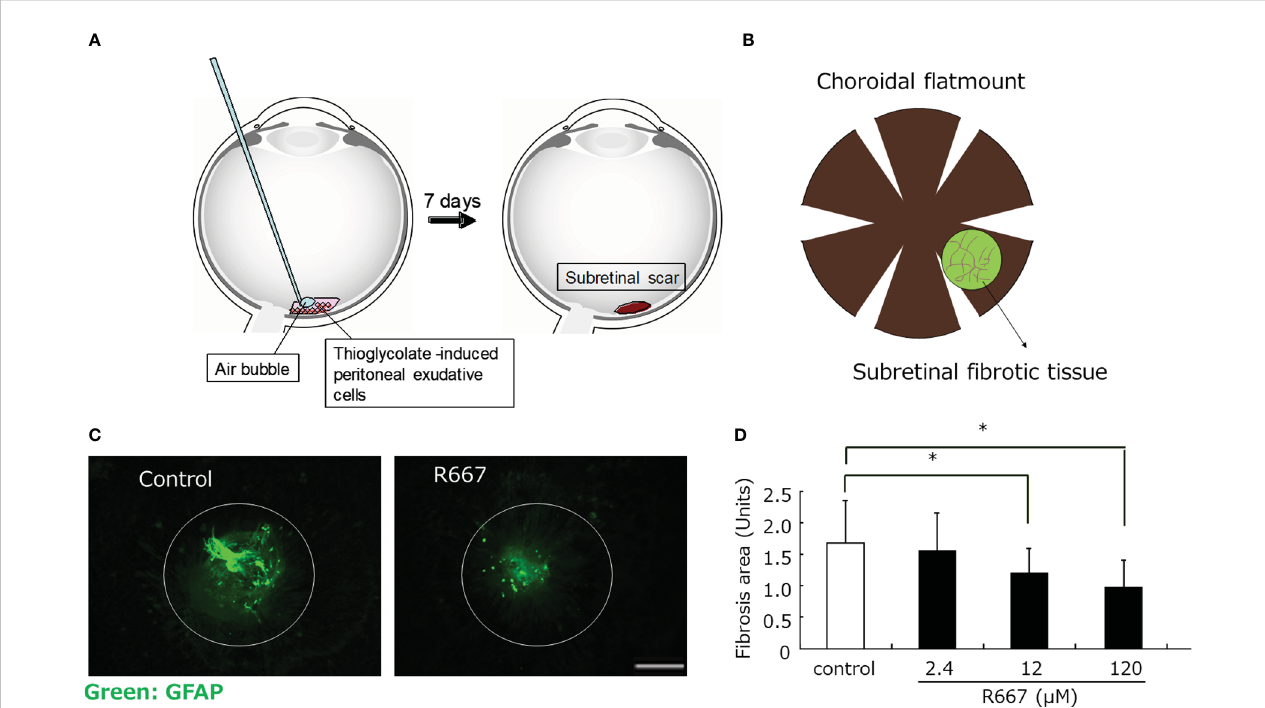
FIGURE 2 Inhibition of subretinal fi brosis by RAR- g agonist(R667) in a mouse model. (A) Retina was subjected to laser photocoagulation (light wavelength, 532 nm; time, 0.1s; spot size, 75 m m; power, 200 mW) in order to generate a subretinal bubble and rupture Bruch ’ s membrane. Thioglycolate-induced PECs (4×10 7 /ml) were exposed to various concentrations of R667 in PBS, and 0.5 m l of the cells was then injected into the subretinal space of the mouse recipients. Seven days after PEC injection, the animals were killed and the eyes were enucleated and fi xed (B) Choroidal fl at-mount preparations were washed with PBS, exposed to 100% methanol at room temperature for 10 min, and incubated fi rst for 1 h at room temperature with 5% skim milk in PBS and then for 24 h at 4°C with (C) Choroidal fl at-mount preparations from mice at 7 days after photocoagulation and injection of PECs treated with or without R667 (120 m M) into the subretinal space were subjected to immuno fl uorescence staining with antibodies to GFAP. GFAP was used as an indirect marker to better visualize fi brotic areas. Scale bar, 200 m m. (D) The area of subretinal fi brosis in preparations similar to those in (C) was determined for R667 concentrations of 0, 2.4, 12, or 120 m M. Data are means ± SEM for 10 eyes per condition. *P<0.05 (Dunnett ’ s